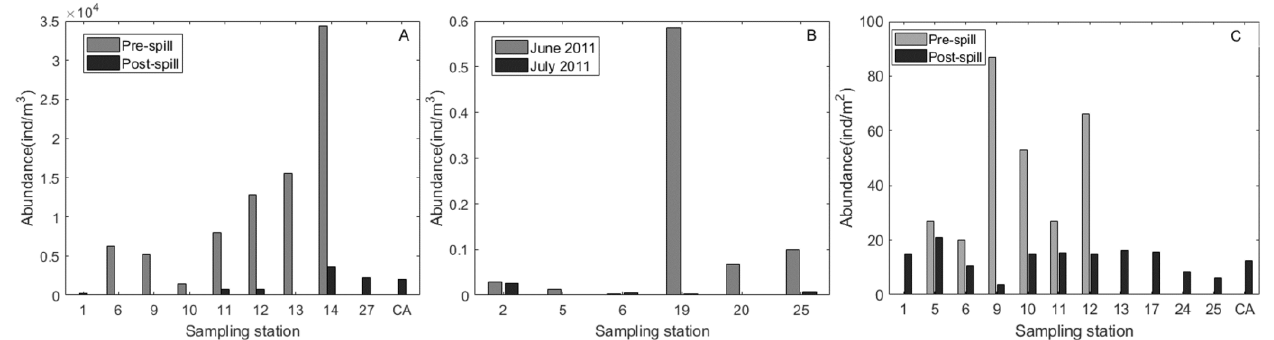
Figure 4. Abundance of Chaetoceros ( A ), Fish larvae ( B ), and Shellfish ( C ) at sampling stations. The average abundances of Chaetoceros and shellfish before the oil spill are 11,941 ind/m 3 and 47 ind/m 2 , respectively. While that after the oil spill are 1651 ind/m 3 and 12.1 ind/m 2 , respectively. In addition, the average abundance of fish larvae in June and July is 0.13 ind/m 3 and 0.007 ind/m 3 , respectively. According to the information of observation (Table 1), Chaetoceros and shellfish were observed before and after the oil spill, fish larvae was observed after the spill in June and July. By comparing the abundance before and after the oil spill, it is found that Chaetoceros and shellfish decreased signifi- cantly in the short term after the oil spill. The oil pollution also had a negative impact on fish